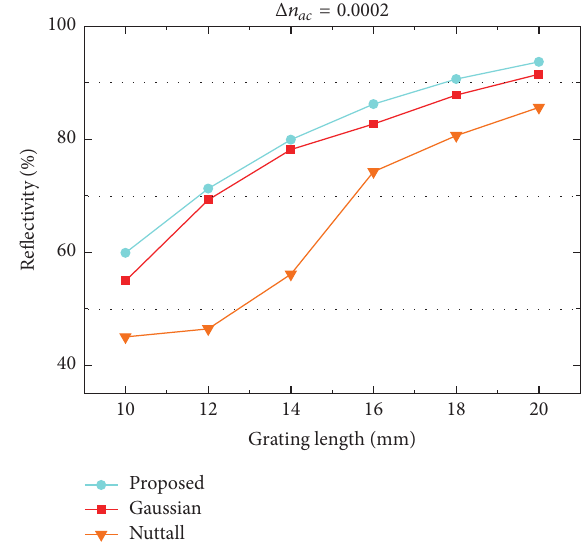
Figure 8: Reflectivity versus grating length.